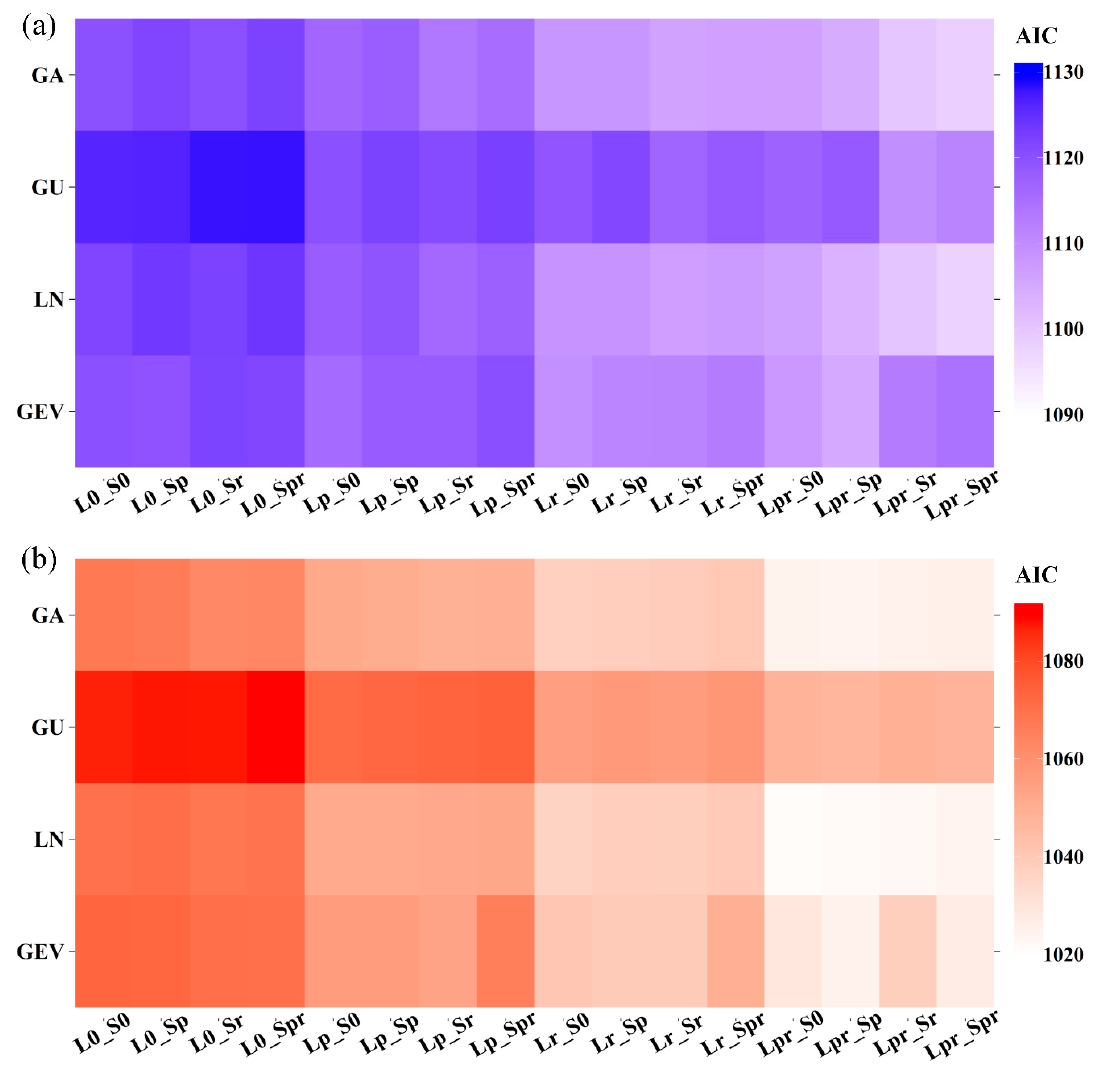
Figure 7. Akaike Information Criterion (AIC) values of the nonstationary models with rain and pop covariates of ( a ) Dahuangjiangkou station and ( b ) Huaxian station. As for centile curves, for Huaxian station, the percentages of observation points below the 5th, 25th, 50th, 75th and 95th centile curves are 3.2%, 33.9%, 45.2%, 69.4% and 95.2% using time covariate, while these percentages are 4.8%, 25.8%, 50.0%, 79.0% and 93.5% using physical covariates (Figure